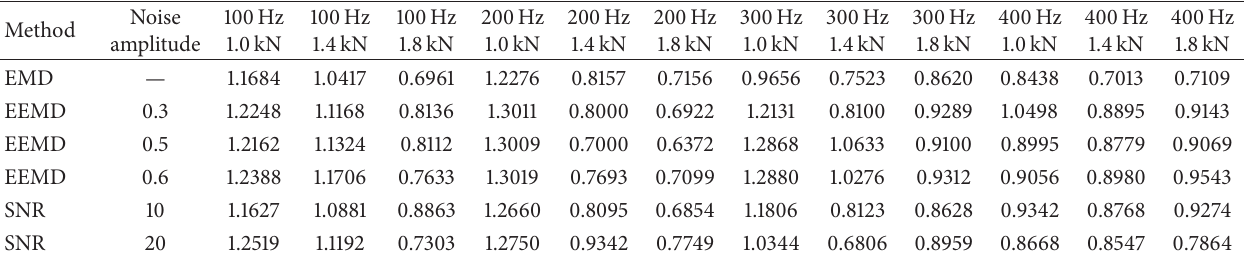
Table 4: The Margin calculated using EEMD with different amplitudes ( 𝑌 direction).